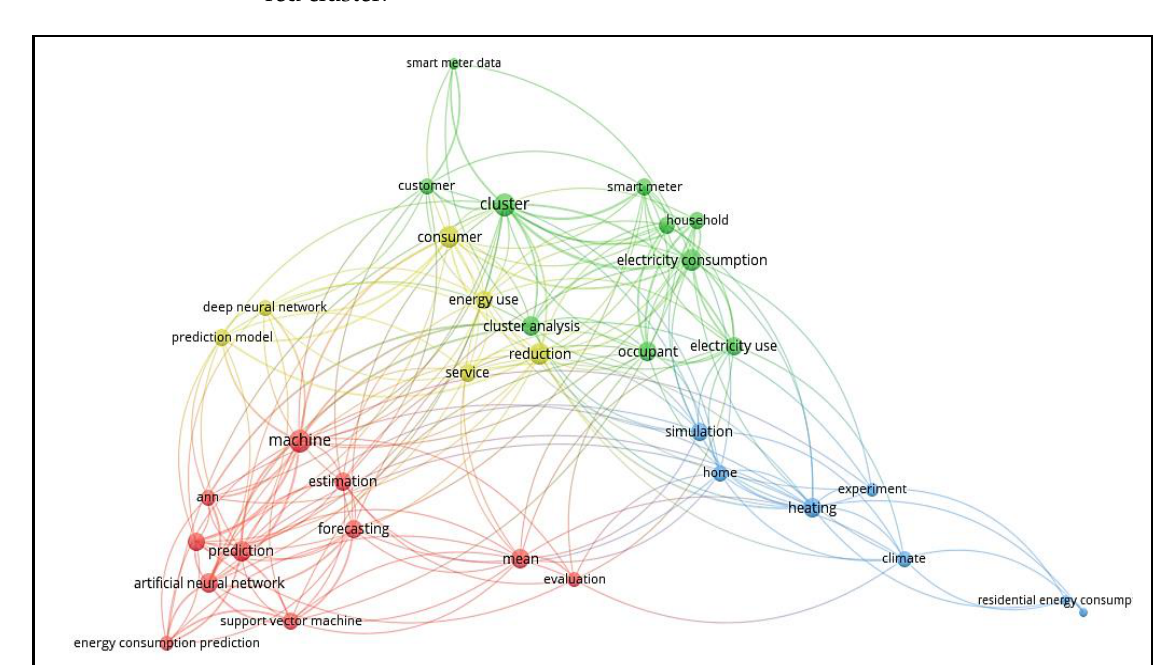
Figure 7. The relationships between the common terms using the bibliometric map.